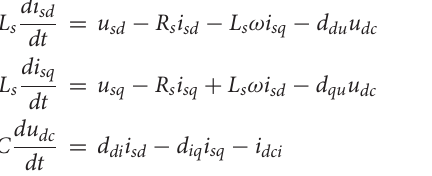
Frontiers in Energy Research |